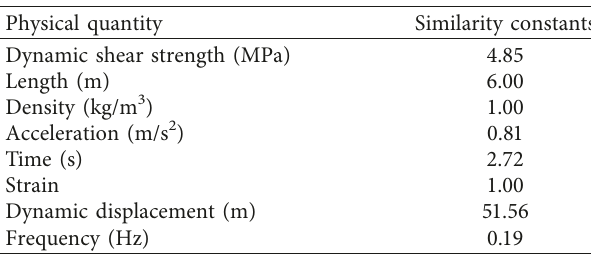
Table 14: Similarity